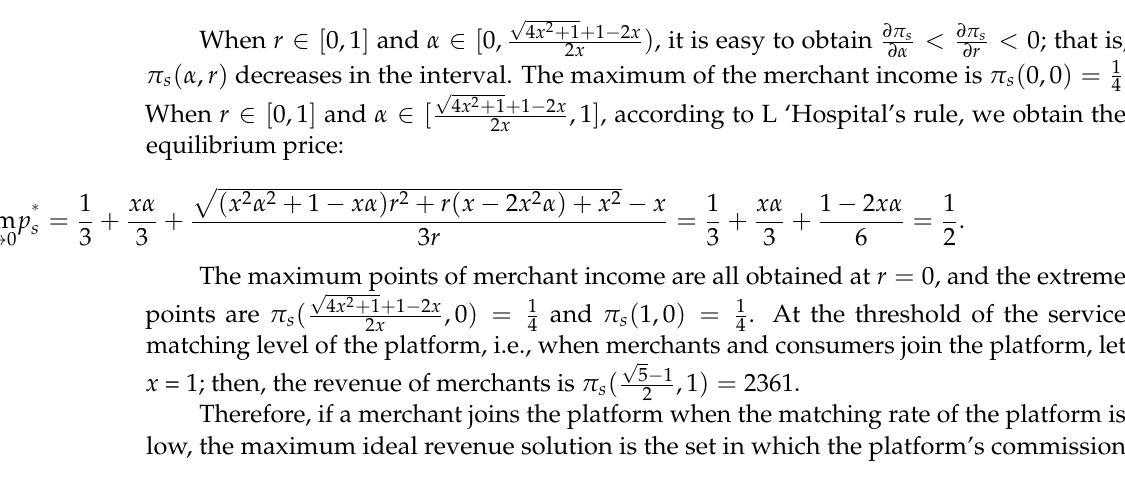
Figure 2. Merchants’ earnings change with service matching level and commission